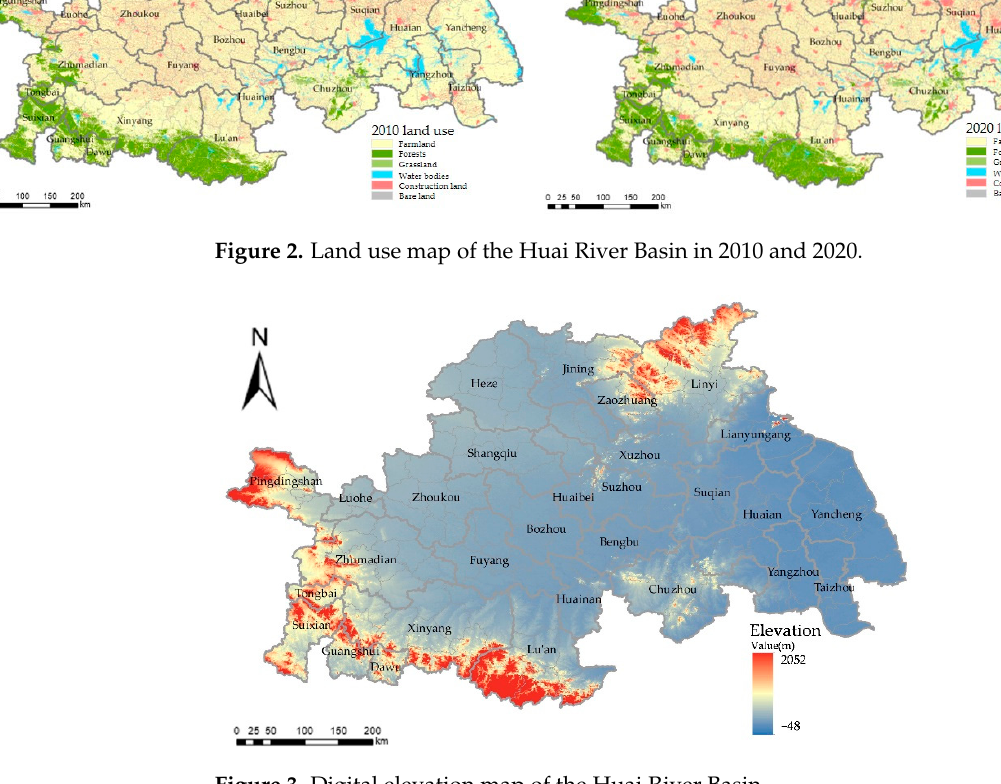
Figure 3. Digital elevation map of the Huai River Basin.